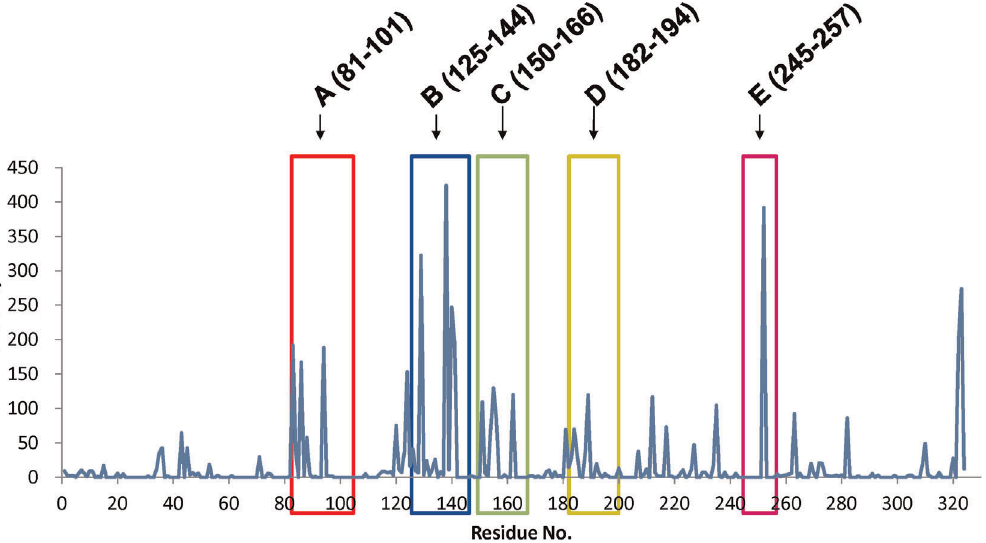
Figure 3. HA sequence alignment. Results from analyses of amino acid variation in the HA1 of 163 avian influenza virus strains reveal five regions with the highest variability scores (0 to 4 based on Vector NTI Tables). HA1 subunit regions A (HA81–101), B (HA125–144), C (HA150–166), D (HA182– 204), and E (HA245–257) were found to have higher scores.